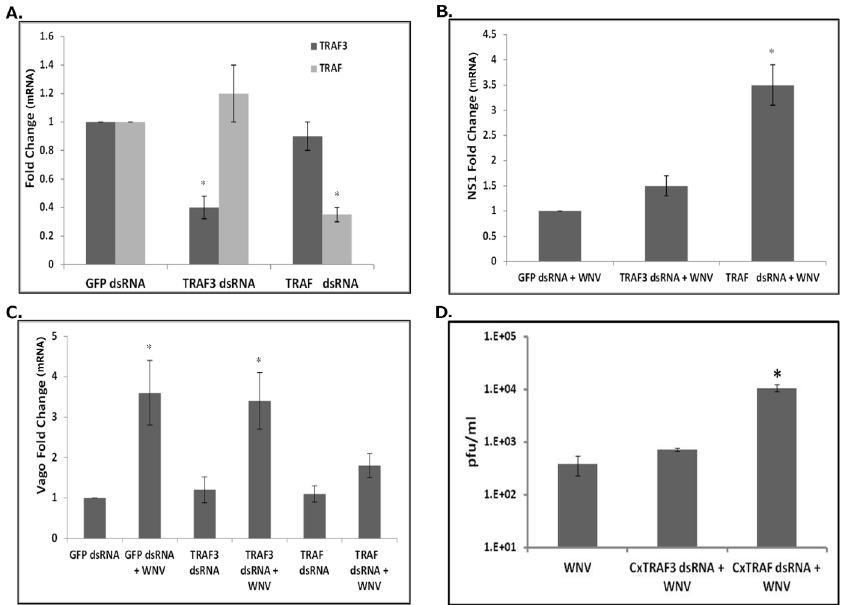
Figure 4. Cx TRAF, but not Cx TRAF3, is required for activation of WNV-induced Cx Vago. Hsu cells were transfected with dsRNA against TRAF-3 (TRAF-3 dsRNA) or TRAF (TRAF dsRNA). GFP dsRNA was used as a silencing control. At 24 h post-transfection, the cells were infected with WNV and total RNA was collected 48 hpi. ( A ) Real-time RT-qPCR was performed on uninfected cells using TRAF-3- or TRAF-specific primers. RpL32 primers were used as internal control. ( B ) Real-time RT-qPCR was performed using Cx Vago primers with RpL32 as control. ( C ) Real-time RT-qPCR was performed using WNV NS1 primers with RpL32 as control. ( D ) Viral titer estimation by plaque assays was conducted on the supernatant media from these cells at 48 hpi. Error bars represents standard error from three separate experiments with assays performed in triplicate (Student’s t-test *p , 0.05, compared to GFP dsRNA).